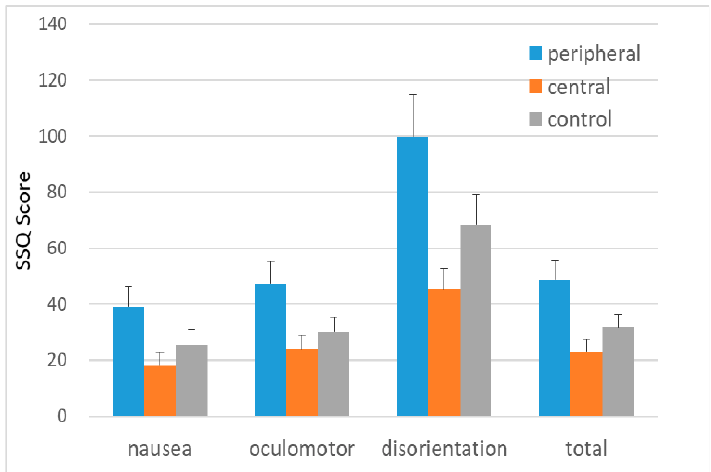
Figure 1. Mean weighted Simulator Sickness Questionnaire (SSQ) scores (with standard error bars) for three experimental groups.